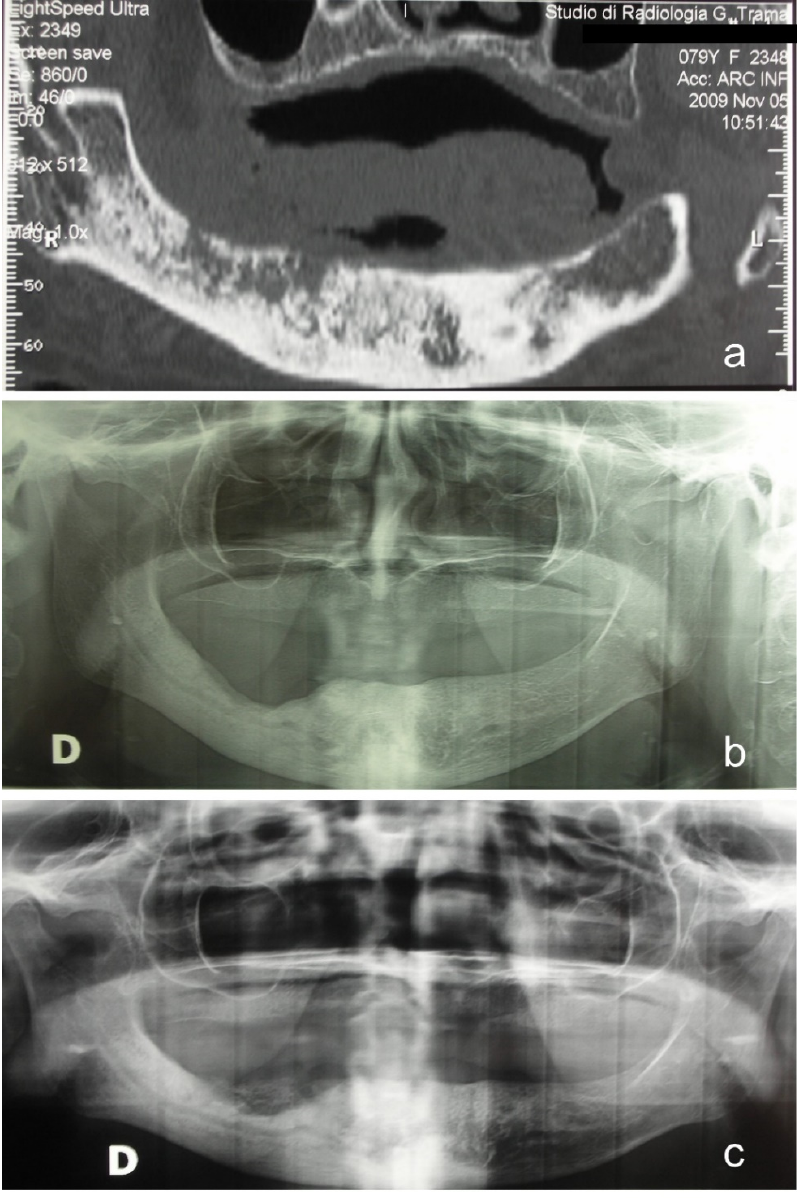
Figure 4. Radiological examination of a treated patient: ( a ) baseline CT taken before surgery; ( b ) postoperative panoramic X-ray, taken 7 days after surgery; ( c ) postoperative panoramic X-ray taken 6 months after surgery.